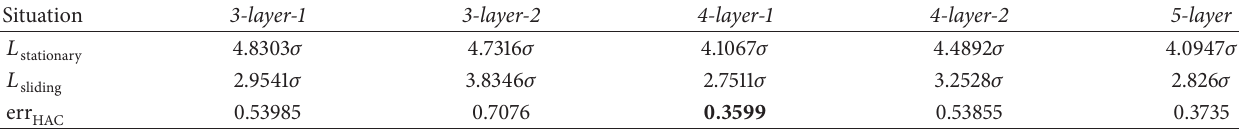
Table 5: Slip length prediction of five combinations and unified relative errors with the fixed width of the overlap region. Situation